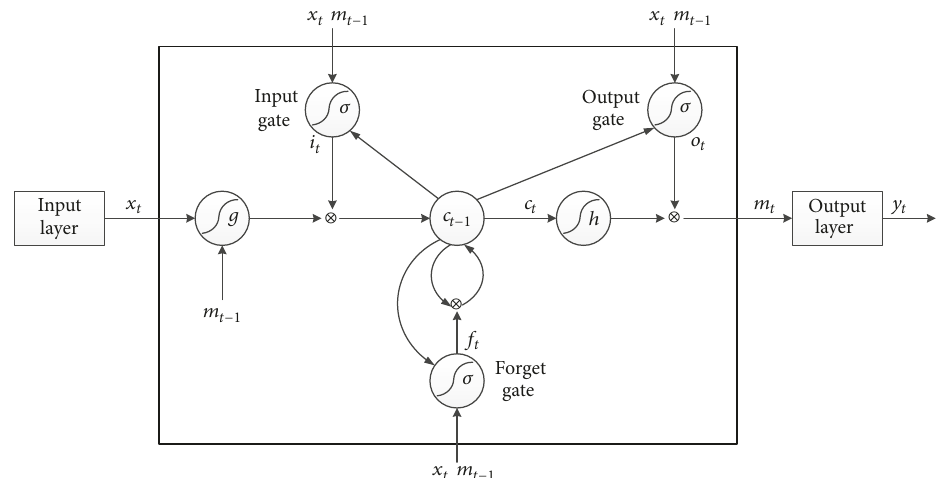
Figure 1: The structure of the LSTM memory